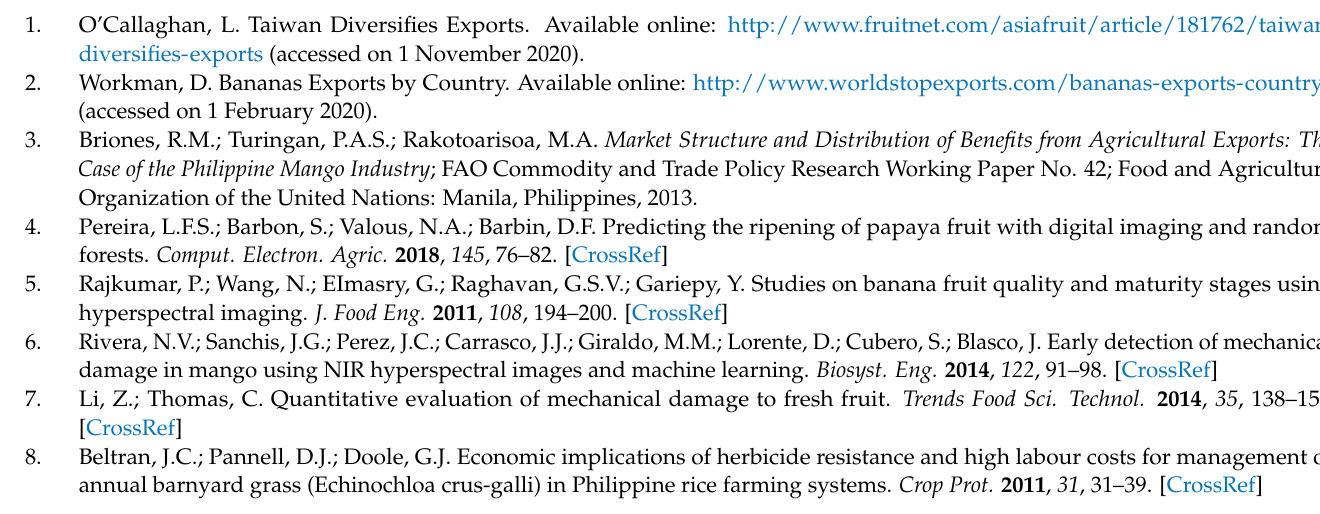
Table S2: Model summary for banana size classification. Table S3: Model summary for banana view